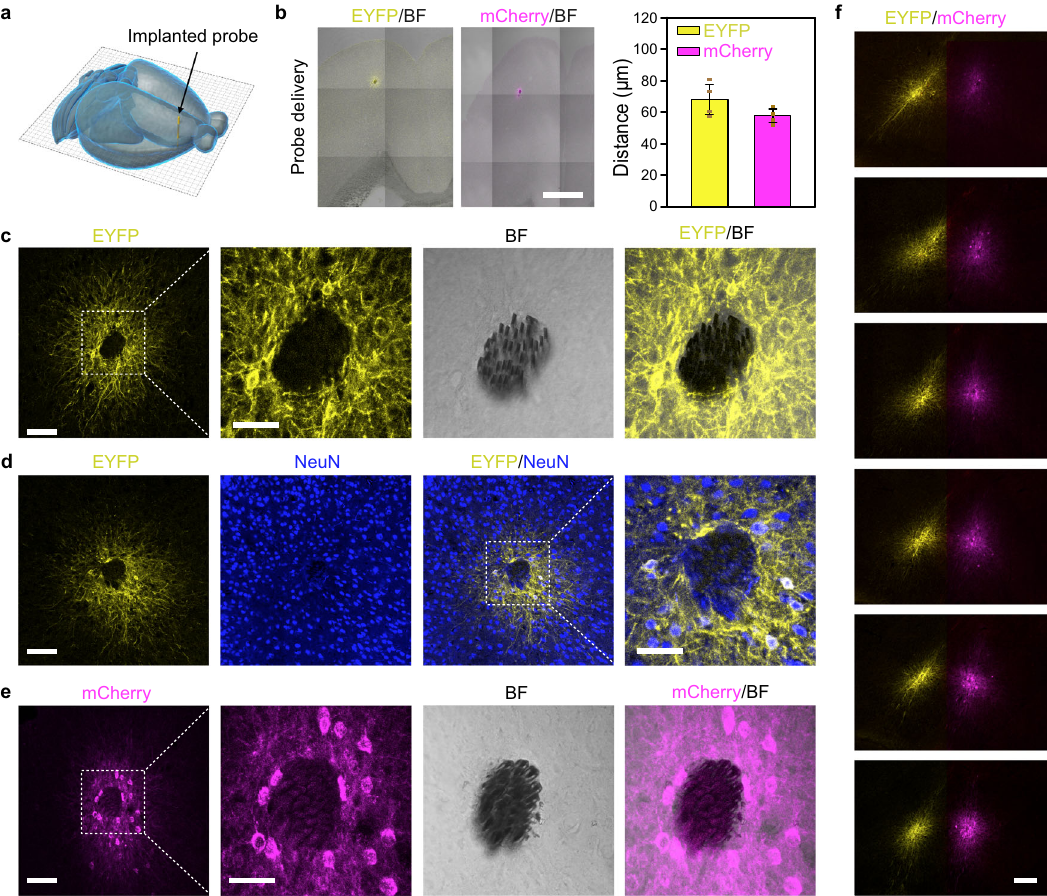
Fig. 2 Spatially con fi ned transgene delivery and neuronal expression in mouse brain. a A schematic showing an implanted AAV-delivery probe in mouse brain. b Transduction characteristics of AAV9 vectors delivered through self-assembled probes. Images (left) are overlays of EYFP/mCherry fl uorescence and bright fi eld. Data (right) represent the mean ± SD ( n = 4 mice in each group). Scale bar, 1 mm. c Spatially localized EYFP expression around implanted MEFs. The MEFs can be seen in the bright fi eld image. d Neuronal expression of EYFP around MEFs. e Spatially localized mCherry expression of an implanted AAV9-hSyn::ChR2-mCherry-delivery probe at 3 weeks. Scale bars in ( c - e ), 100 and 50 μ m (magni fi ed views). f Spatially con fi ned transgene expression of two closely implanted self-assembled probes in the same mouse brain. One probe was loaded with AAV9-hSyn::eNpHR3.0-EYFP (left), and the other was loaded with AAV9-hSyn::ChR2-mCherry (right). Scale bar, 200 μ